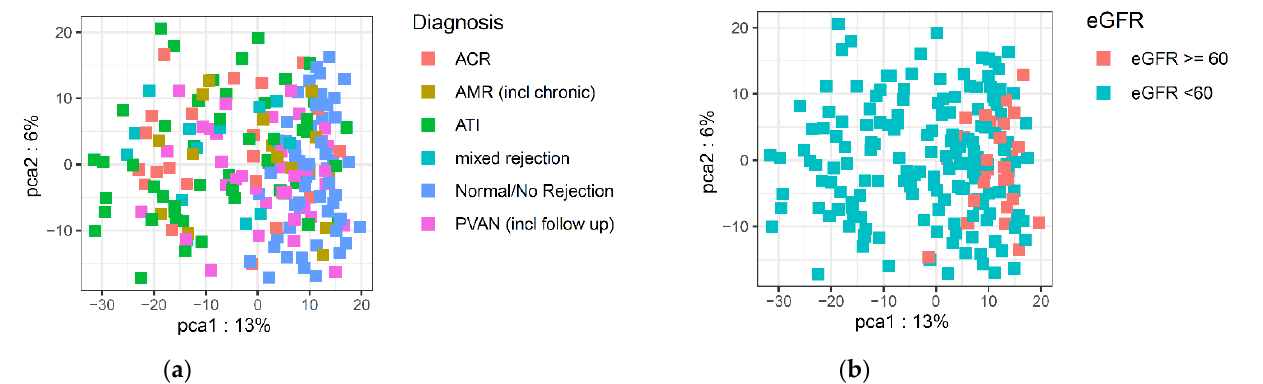
Figure 1. Principal component analysis (PCA) plots of the urinary metabolomics data, colored by “diagnosis” ( a ) and “eGFR” ( b ).